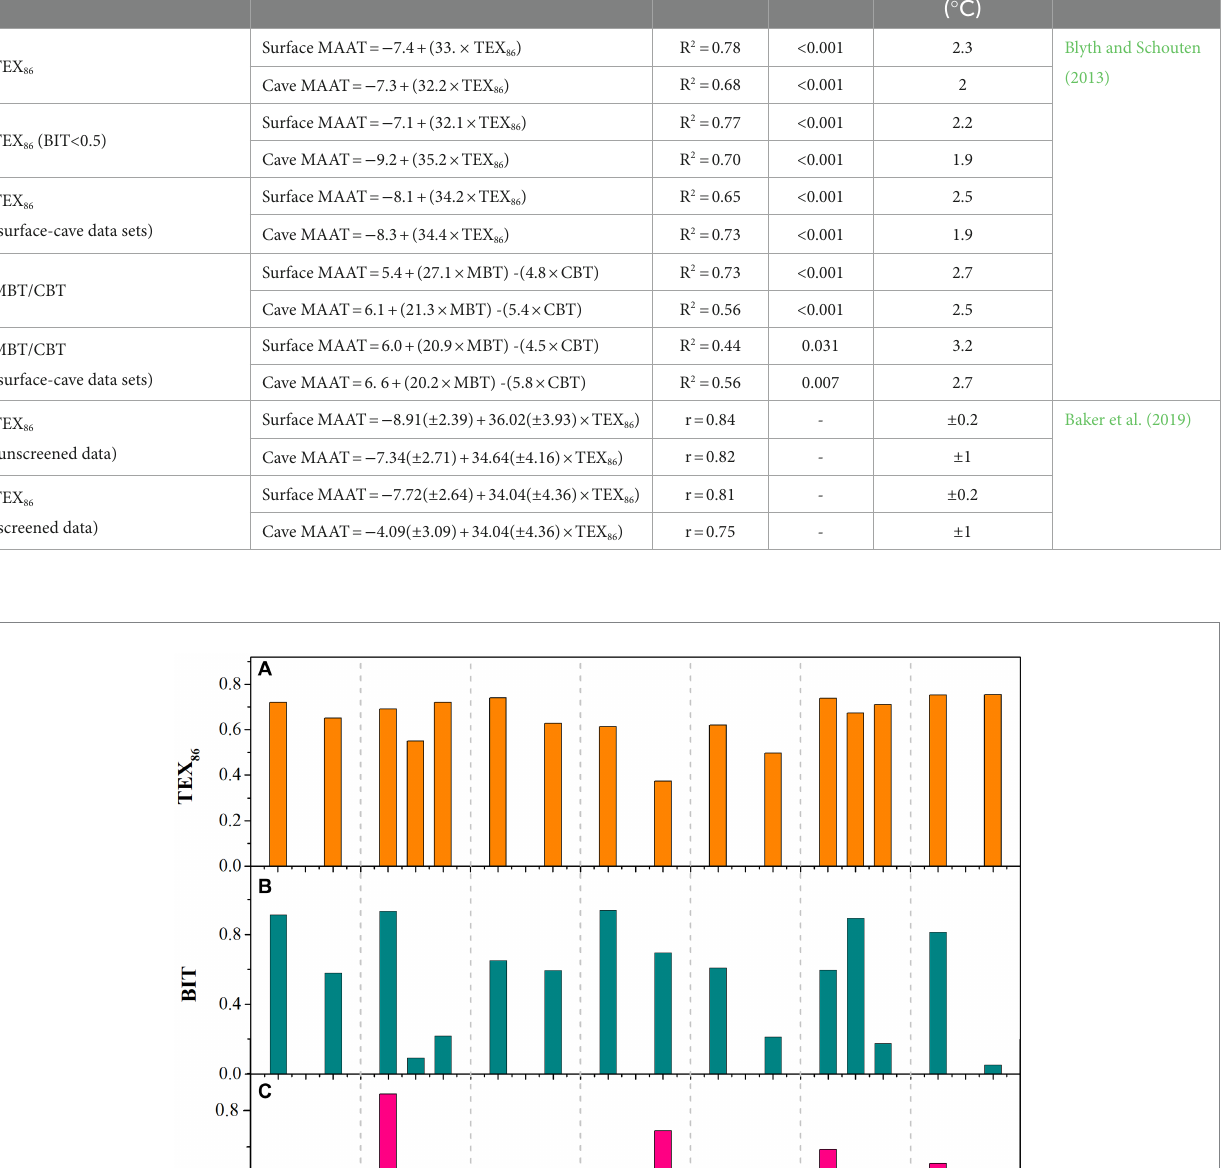
TABLE 2 Correlations of TEX 86 and MBT/CBT based on stalagmite GDGTs. Proxies